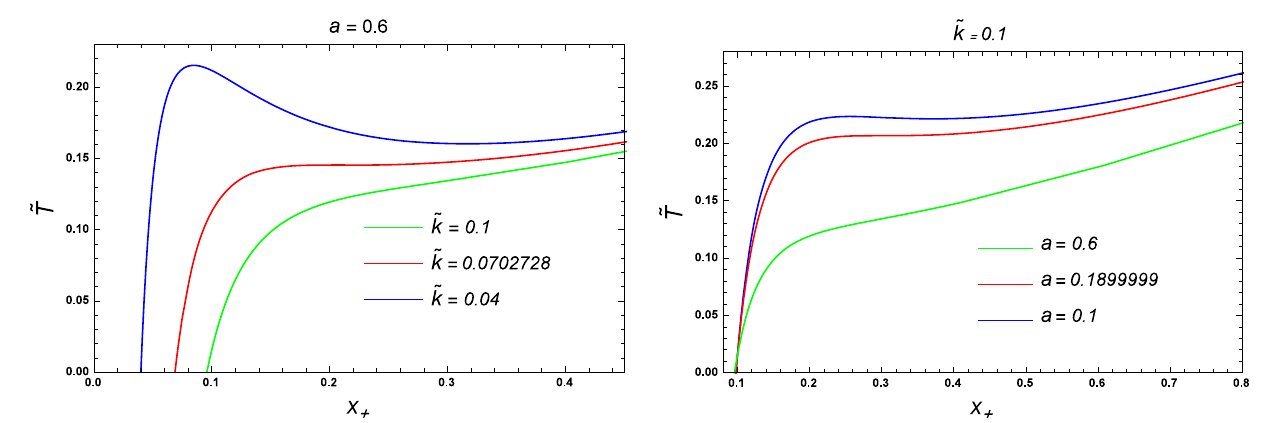
Fig. 4 The Hawking temperature ˜ T vs horizon x + for a = 0 . 6 vary- ing ˜ k with ˜ T max = 0 . 215369 , ˜ T min = 0 . 160236 for ˜ k = 0 . 04 (left), and for ˜ k = 0 . 1 varying a with ˜ T max = 0 . 223639, ˜ T min = 0 . 221622